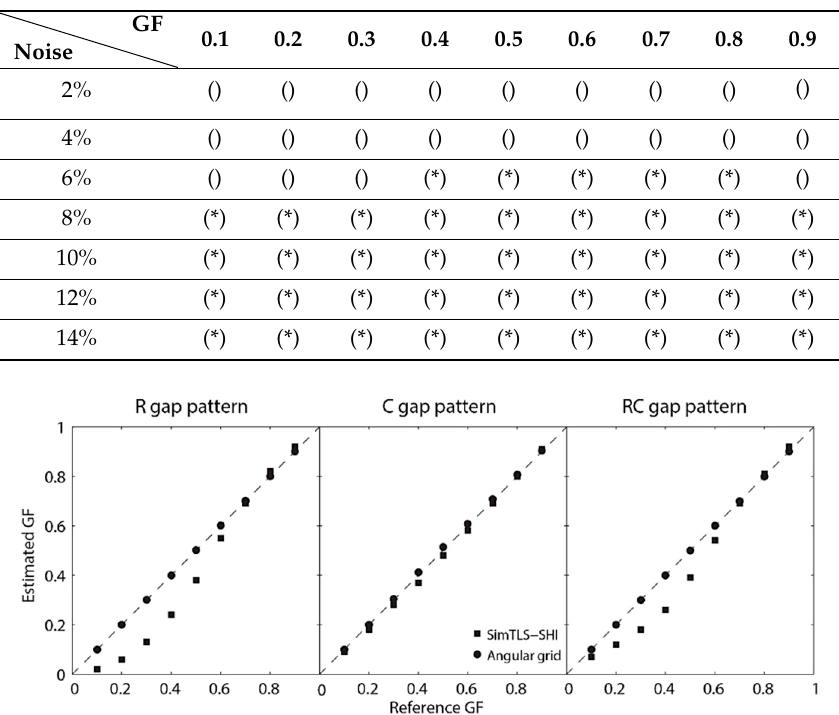
Figure 8. Comparison between reference and computed GF for R, C and RC gap patterns in the simulated angular data. The 2% noise marker is bigger for visualization purposes. Table 2. Statistical differences ( p -value < 0.01*) according to the KW test between angular grids with R, C and RC gap patterns, 2–14% noise and 0.1–0.9 GF.